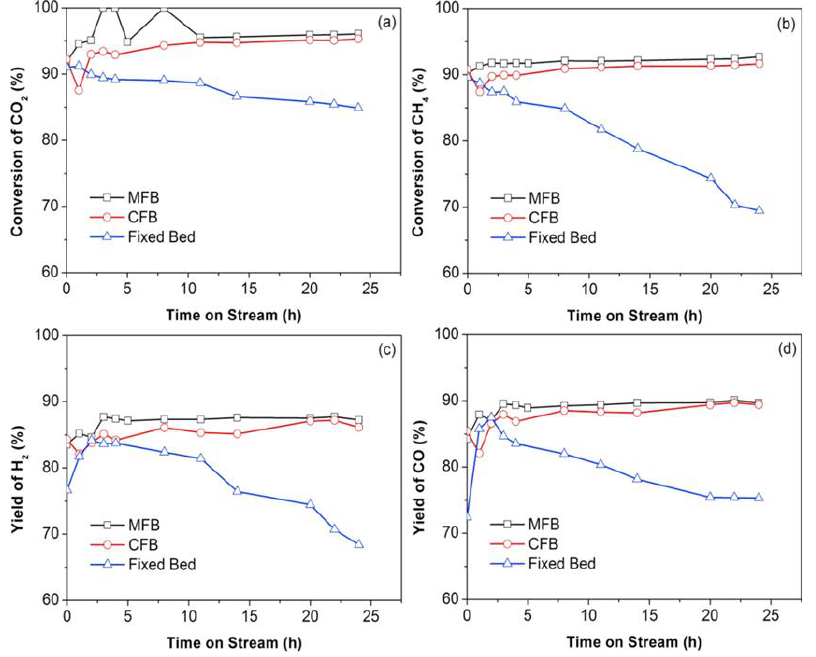
Figure 17. Catalytic stability experiments with GHSV of 60,000/ h. Conversions of ( a ) CO 2 , ( b ) CH 4 , the yields of ( c ) H 2 and ( d ) CO. Reprinted from [115]. Copyright (2018), with permission from Elsevier.